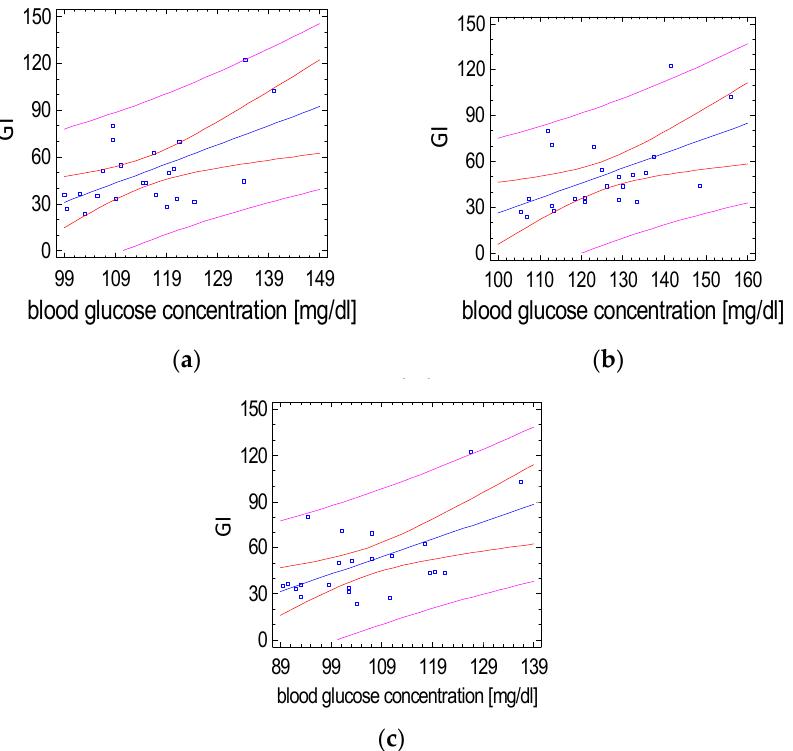
Figure 6. Relationship of the GI value of white rice with the plant-based formula and postprandial glucose concentration at ( a ) 15 min, ( b ) 30 min and ( c ) 120 min after its consumption (Spearman’s correlation test). (the red lines define prediction limits; the pink lines define confidence limits (95%); the blue dots are the results